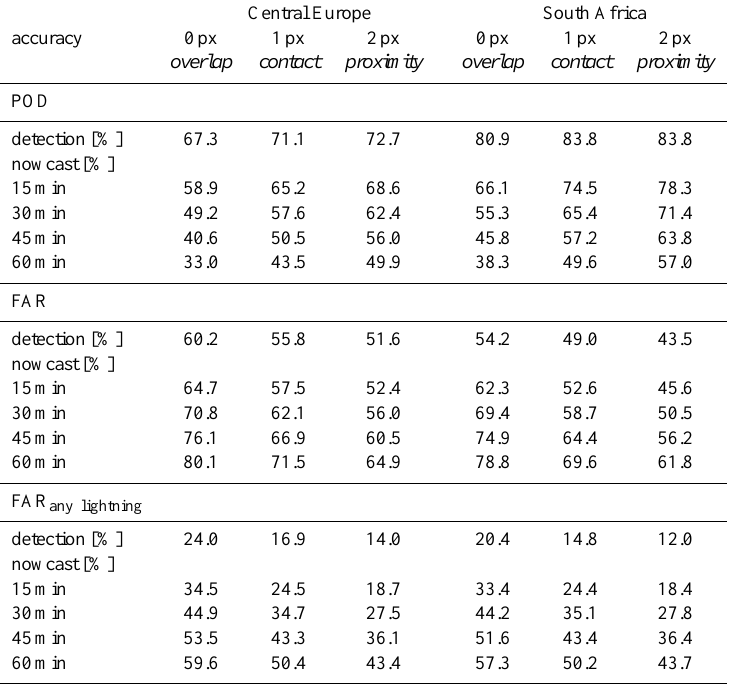
Table 3. Object-based validation scores for the current Cb-TRAM detection scheme for mature storms during daytime, and the 15, 30, 45 and 60min forecasted objects. Top – POD for intense lightning objects ( > 10flashespixel − 1 15min − 1 ); centre – FAR with regard to intense lightning objects ; bottom – FAR any lightning with regard to objects containing any lightning ( > 0flashespixel − 1 15min − 1 ). Central Europe contact proximity overlap